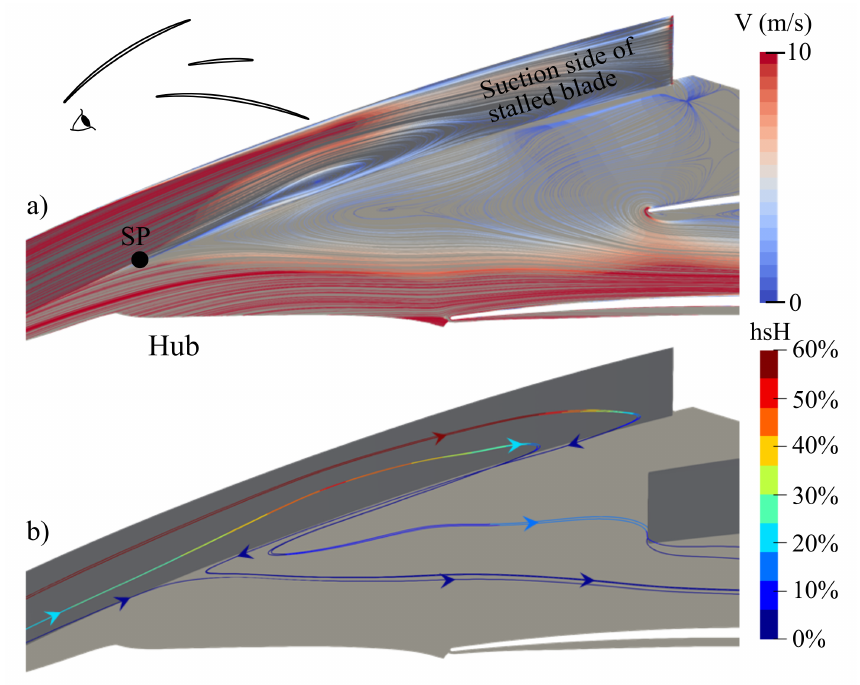
Figure 13. Topological structure at the corner suction side of the stalled blade/hub in the stalled channel at OP2: ( a ) friction lines colored by the velocity and ( b ) 3D streamlines generated from the SP and colored by the span